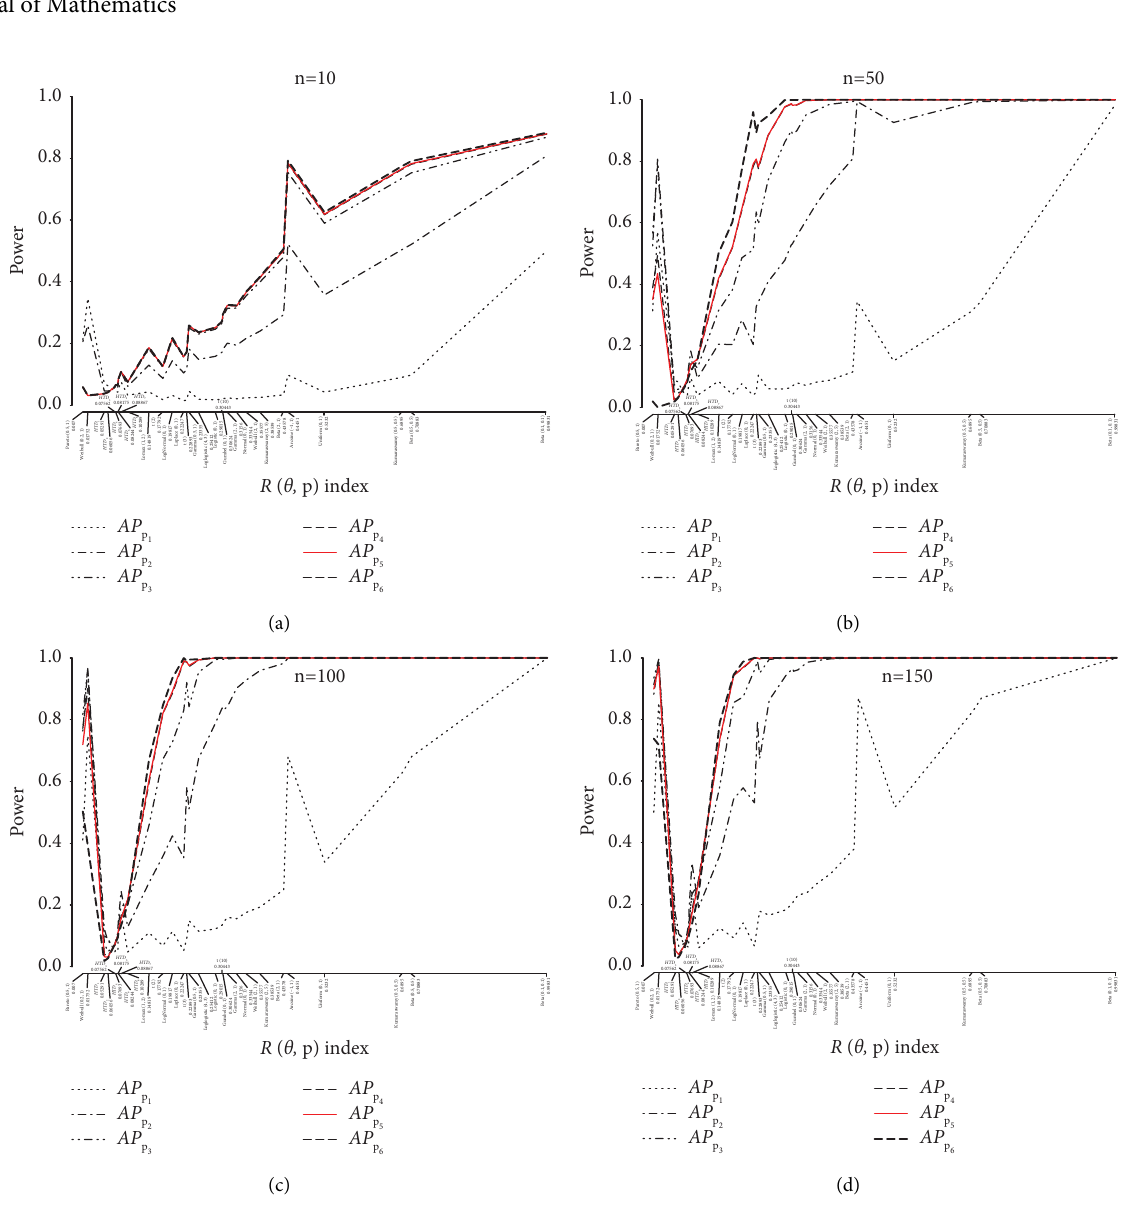
Figure 4: Power graphs based on R ( θ , p ) index for diferent sample sizes. (a) n � 10. (b) n � 50. (c) n � 100. (d) n �